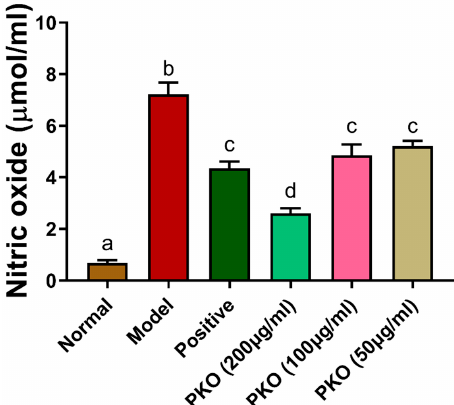
Figure A1. The potential anti-inflammatory function of peach kernel oil on suppressing nitric oxide (NO) release from RAW264.7 macrophage cell lines after challenged with lipopolysaccharide (LPS). Different labels above columns indicate a significant difference tested by One-way ANOVA and Tukey-HSD test with p < 0.01. For normal group, there are no chemicals were added. For model group, lipopolysaccharide (LPS) at 1 μ g/mL concentration was used to induce inflammation and nitric oxide (NO) release. For positive group, dexamethasone at 1 μ g/mL concentration was co-incubated with LPS at 1 μ g/mL concentration to attenuate inflammation and nitric oxide (NO) release. For Peach kernel oil (PKO) groups, PKO at different concentration of 200, 100 and 50 μ g/mL were co-incubated with LPS at 1 μ g/mL concentration to test its potential function on anti-inflammation and suppress NO release.